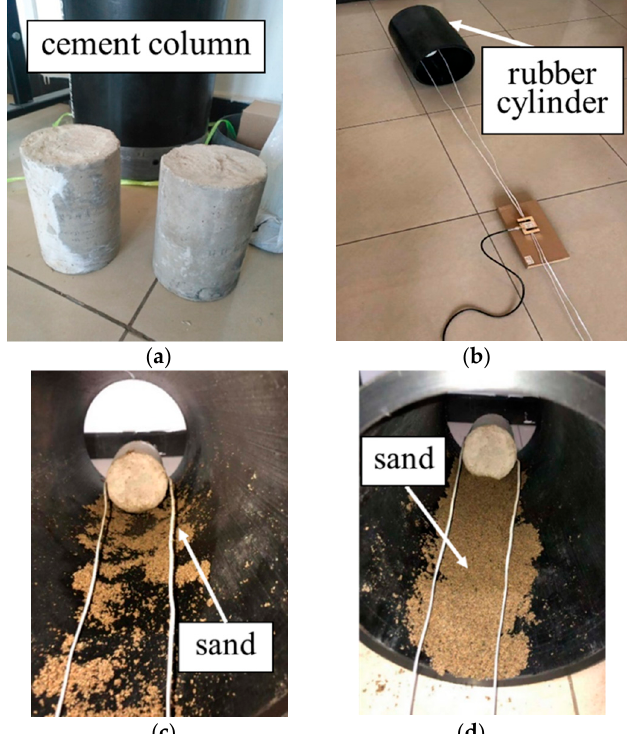
Figure 4. Schemes of the packer in the horizontal hole: ( a ) The packer simulated by a cement column; ( b ) the packer in the horizontal hole simulated by a rubber cylinder; ( c ) the hole with little cuttings; and ( d ) the hole with lots of cuttings.